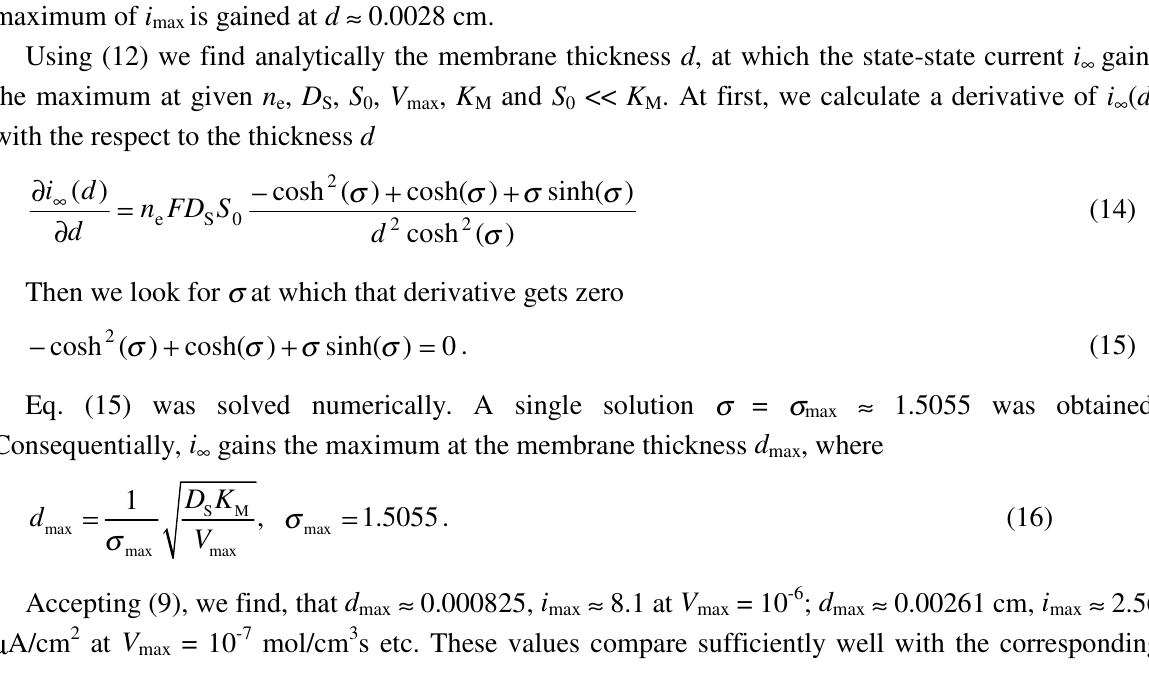
Figure 2 . The dependence of the maximal biosensor current i max on the thickness d of the enzyme membrane at four maximal enzymatic rates V mol/cm 3 s, S = 2 · 10 -8 mol/cm 3 . Symbols are numerical solutions, while lines are analytical ones 0 (formula